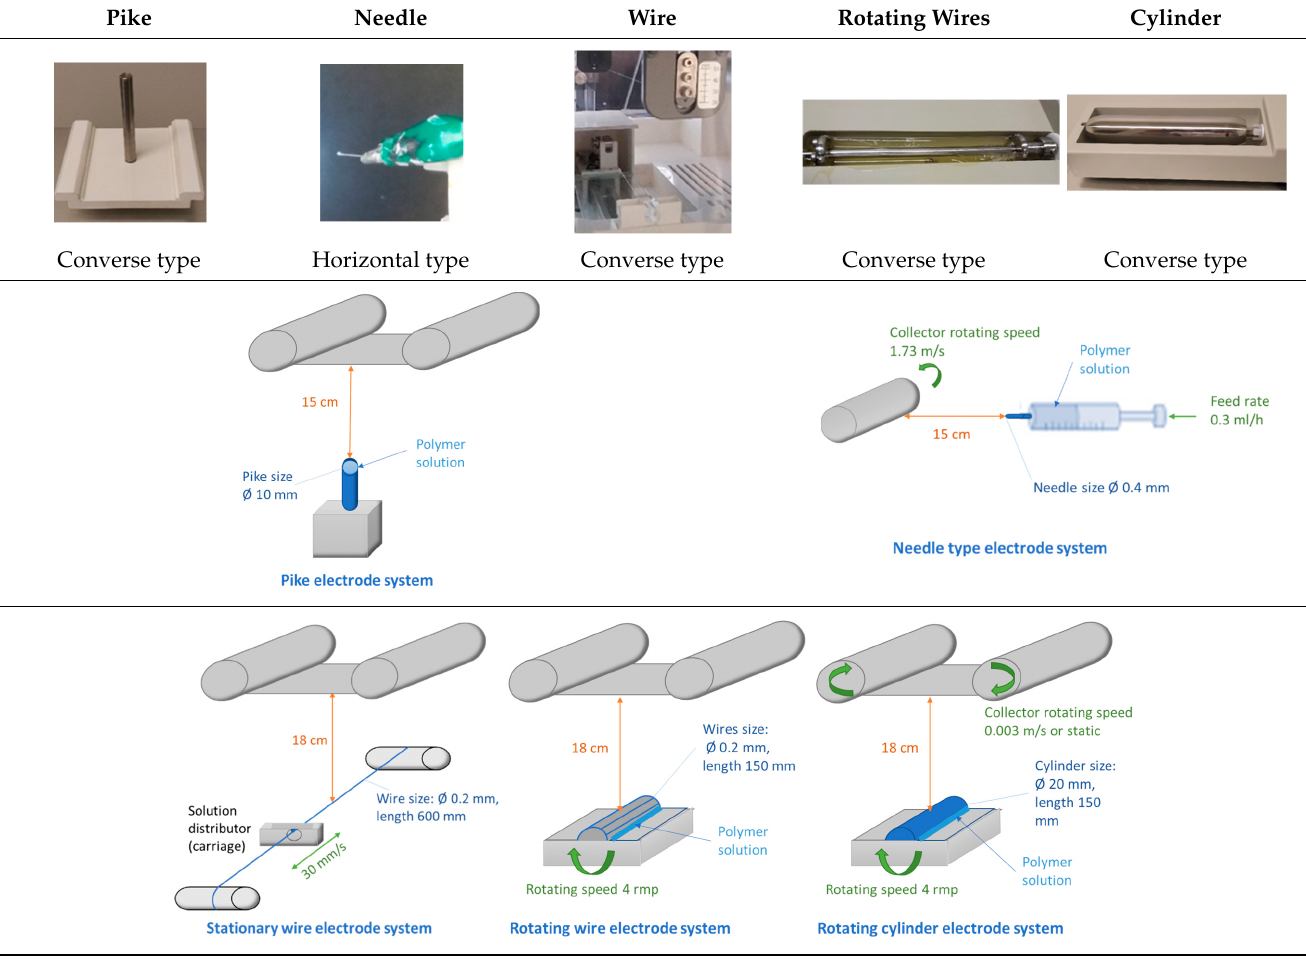
Table 3. Spinning systems depending on electrode type.